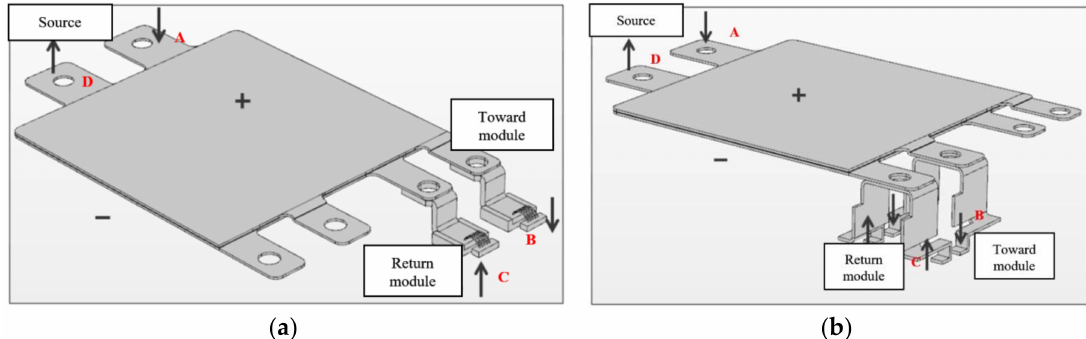
Figure 4. Current inlets and outlets: ( a ) Module M; ( b ) Module K.